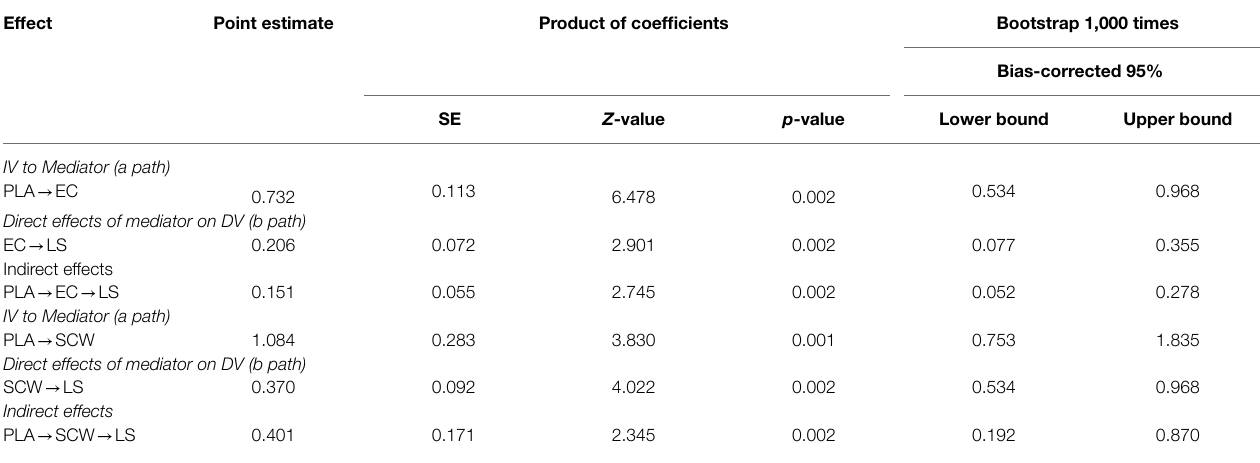
TABLE 9 | The analysis of indirect